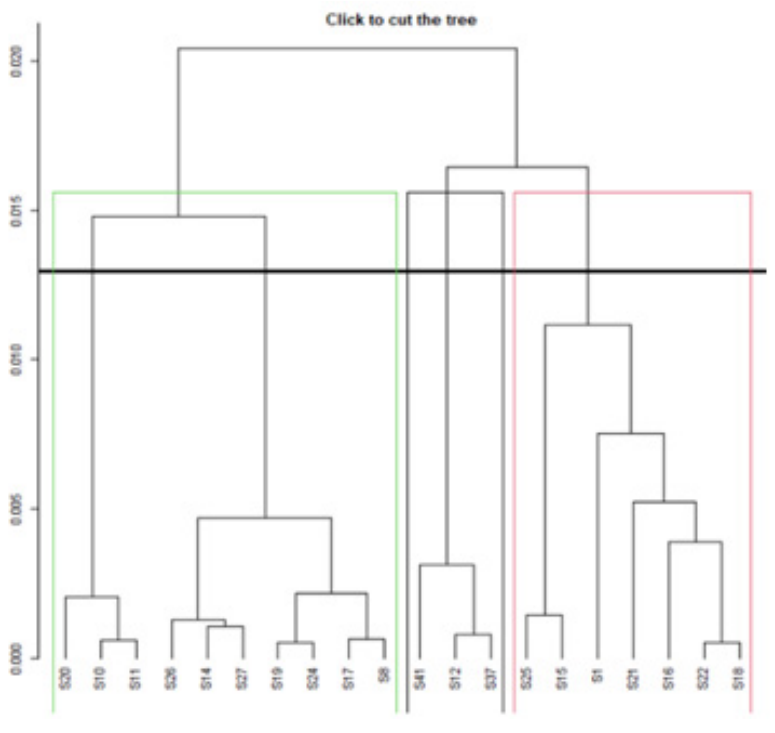
Figure 4. Individual items dendrogram for the SOHP scale with 20